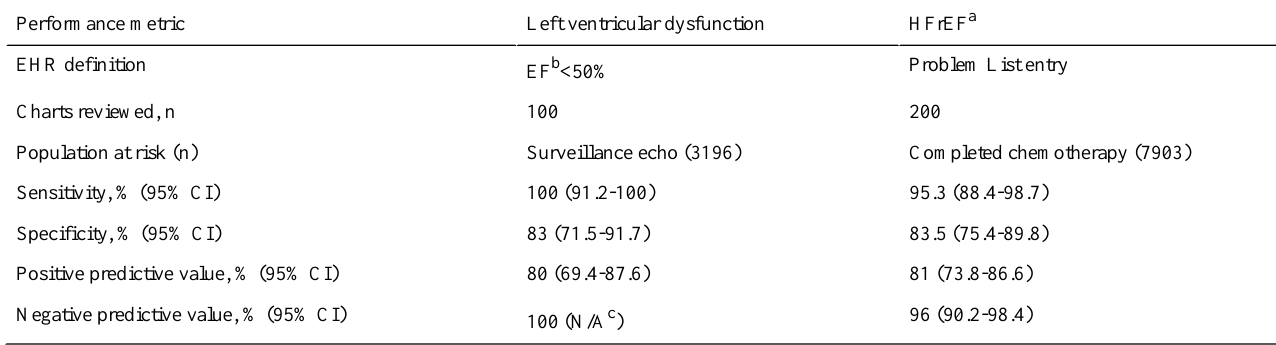
Table 2. Validation of electronic health records (EHR)-based outcomes